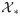
Extended image analysis pipeline concept.Extracted output information of each operator can be filtered according to its uncertainty (*1), operators can access information produced by penultimate predecessors (*2) and processing operators can specifically adjust their processing behavior based on FSMD values of extracted information. Solid lines indicate the main information flow, dash-dotted lines the propagation of previously calculated results and dotted lines emphasize influence on the selection of propagated information. In addition to the flow of extracted features (X*, Ω*, X˜*, Ω˜*), the operators may pass processed images, image parts or forward the input image (I*) to the subsequent processing operator.